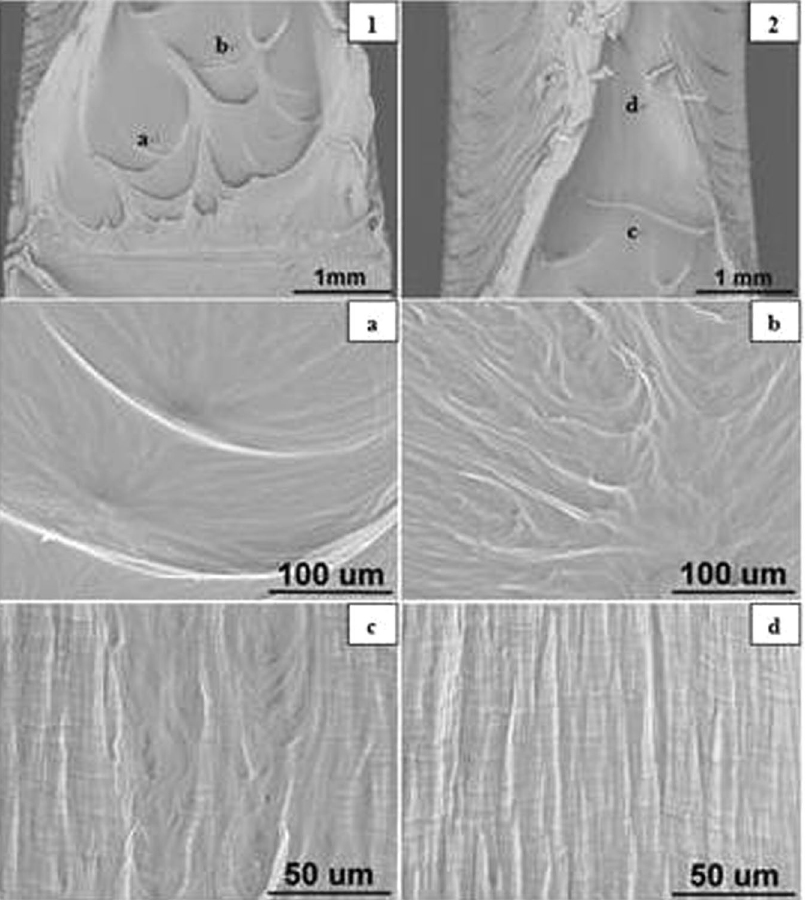
Figure 13. SEM images of blunt notched HDPE fracture surfaces at 50.0 mm/min (1) notch at the bottom, crack propagating from bottom to top; (2) top of propagation at 25